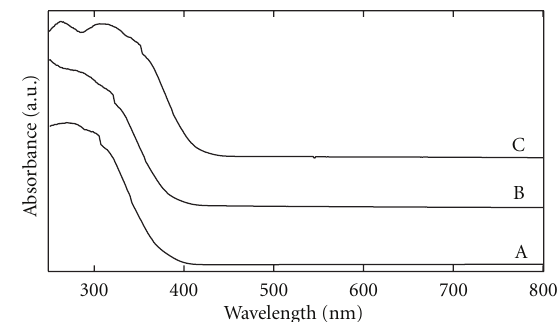
Figure 2: Di ff use reflectance UV-vis absorption spectra of Ti-HMS (A), PAD-Au/Ti-HMS (B) and img-Au/Ti-HMS